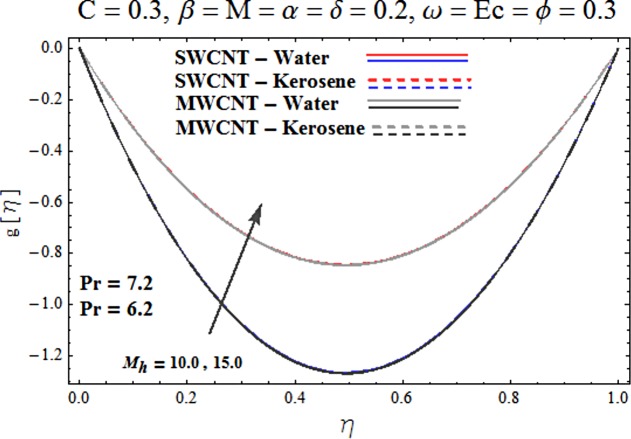
Effect of Mh on g′.